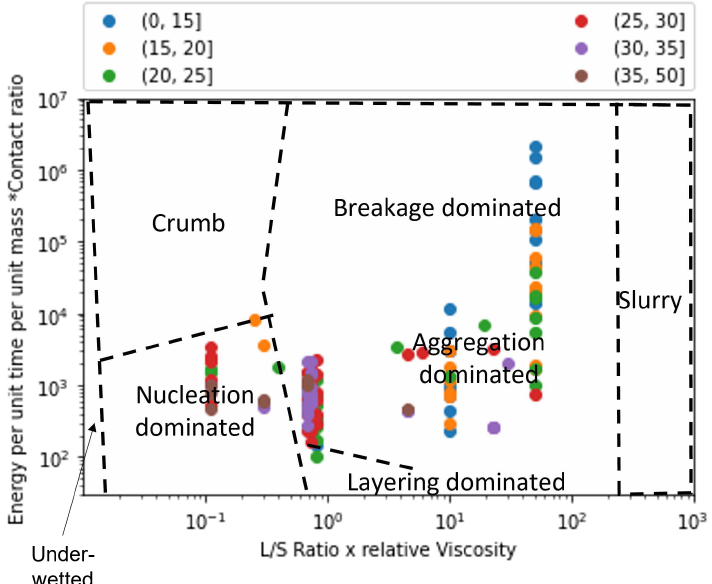
Figure 8. The regime map developed with proposed boundaries and each point colored according to the extent of granule formation. Extent of granule formation is defined as the ratio of the final median diameter of the obtained granules to the initial median diameter of the powder blend.